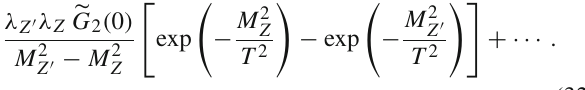
QCD sum rules for the octet and decuplet baryon